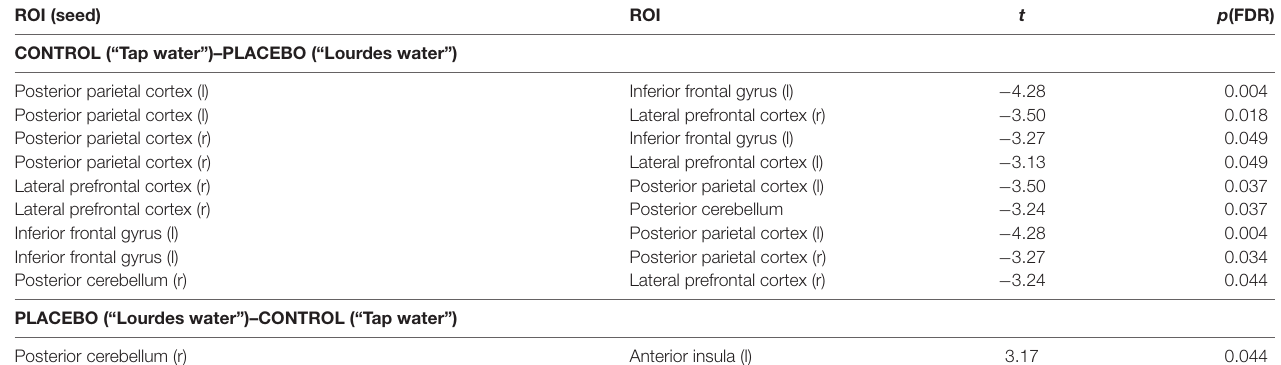
TABLE 2 | Results of the resting-state functional connectivity analysis. ROI (seed) ROI